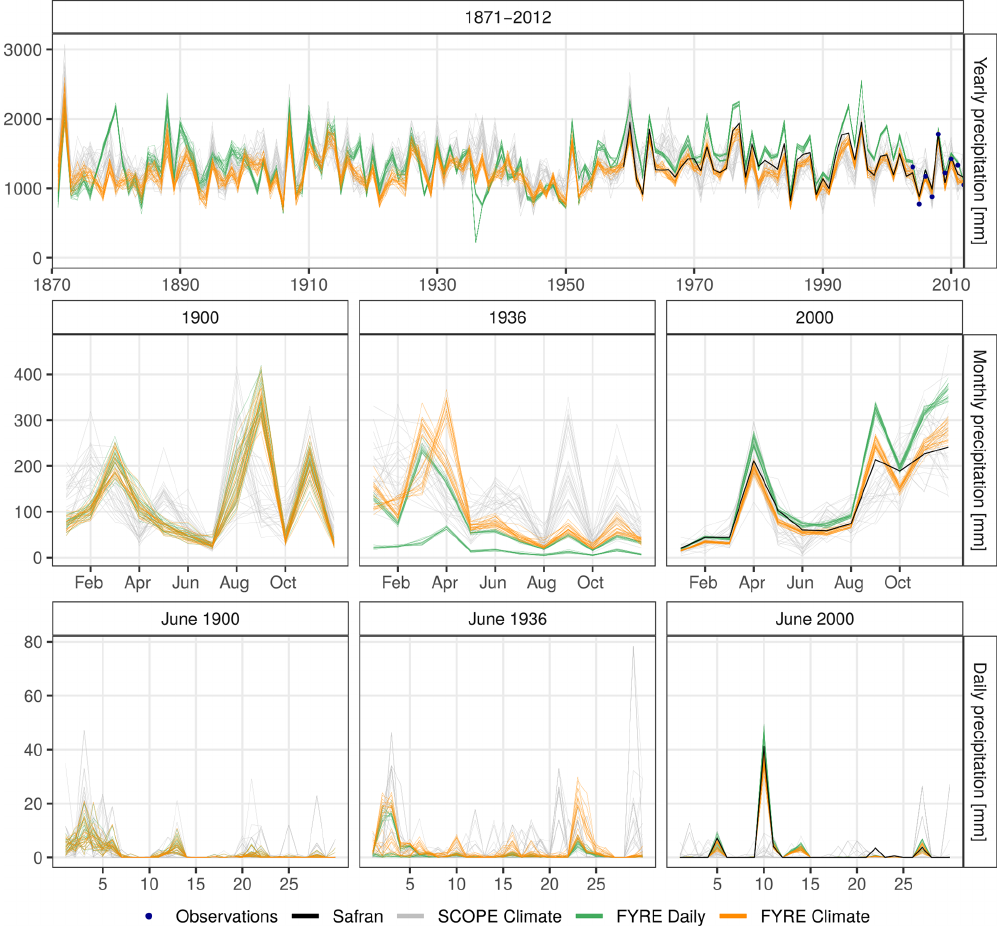
Figure 10. Similar to Fig. 9, but for